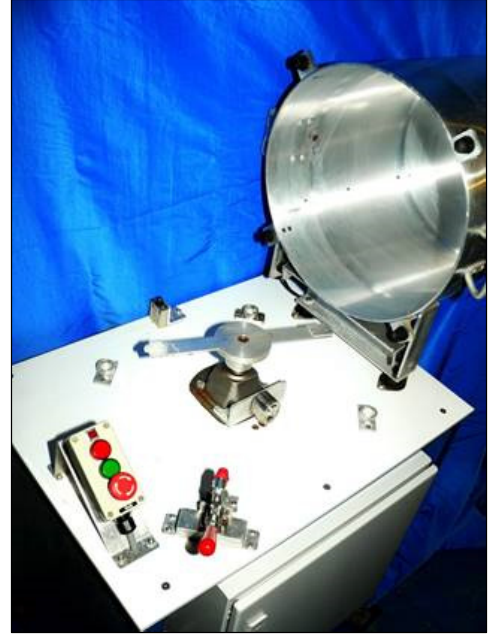
Figure 1. Overview of the centrifuge apparatus. Equipped with an accelerometer, the iced beam is rotated until the ice is detached and captured by the pan.